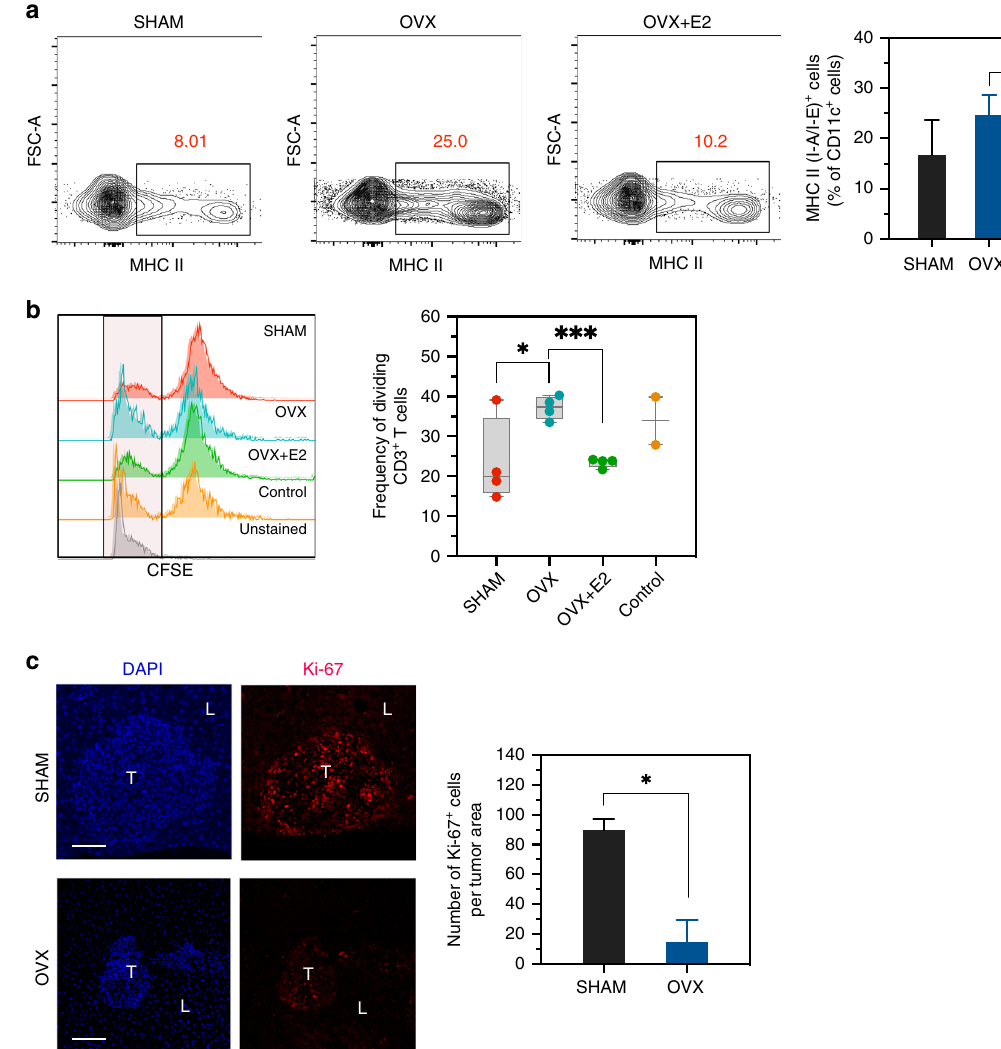
Fig. 8 Estrogen deprivation alters myeloid cell function in the liver TIME. FC was performed on immune cells isolated 7 days post intrasplenic/portal injection of 5 × 10 5 MC-38 cells and immunostained with the indicated antibodies. Shown in a are representative fl ow cytometric contour plots obtained with each of the indicated immune cell populations (left) and in the bar graph (right) the relative frequency of CD11c + MHC II (I-A/I-E) + cells per liver, based on a pool of fi ve livers per group analyzed in triplicates. Shown in b (right) are representative results of a T cell suppression assay using liver-derived MDSC from sham, OVX, and OVX + E2 mice and in b (left) individual results obtained with each of the replicates per group (horizontal bars denote means). Shown in c are representative confocal images from sections of livers immunostained with the indicated antibodies followed by Alexa Fluor 568 (red) for Ki-67 and 4 ′ ,6-diamidino-2-phenylindole (DAPI; blue, left) and the number of Ki-67 + cells per tumor area (right; means ± s.e.m.) of the indicated cells per fi eld counted in 10 fi elds. * − p ≤ 0.05; **- − p ≤ 0.01; *** − p ≤ 0.001; NS, not signi fi cant as determined by the Student's t -test. Box and whiskers graphs: the box extends from the 25th to 75th percentiles, the middle line denotes the median and the whiskers extends from the minimum to the maximum value. Scale bars correspond to 100 µ m on IF